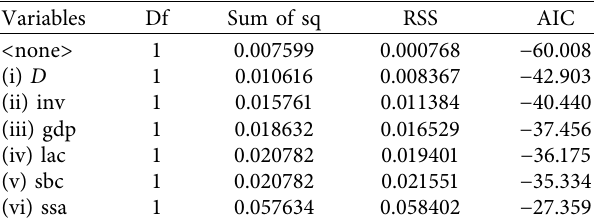
Table 9: Stepwise regression analysis final results.